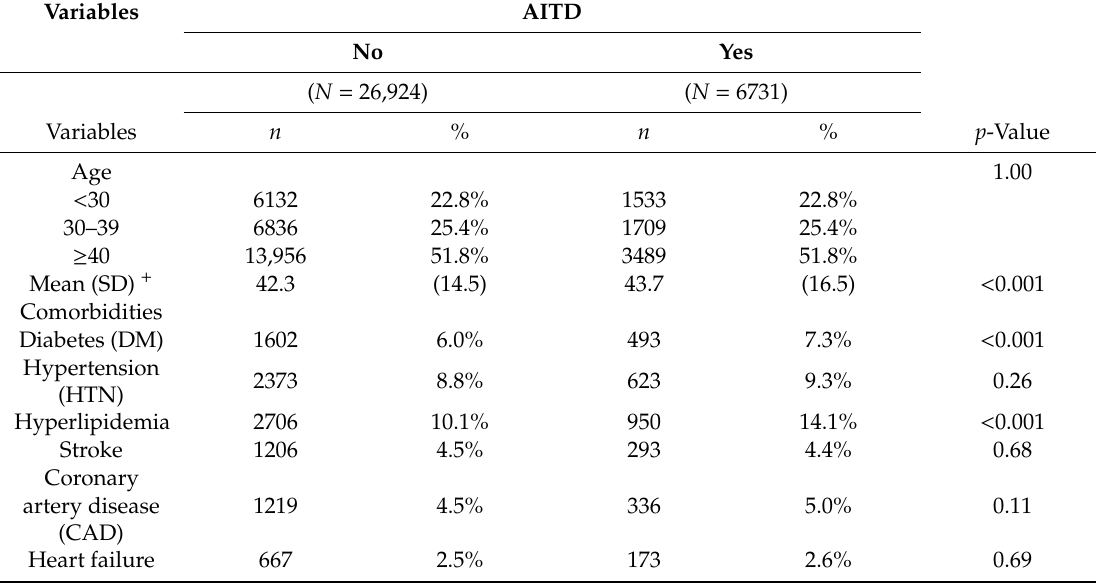
Table 1. The baseline characteristics of the autoimmune thyroid disease (AITD) patients and controls. Variables